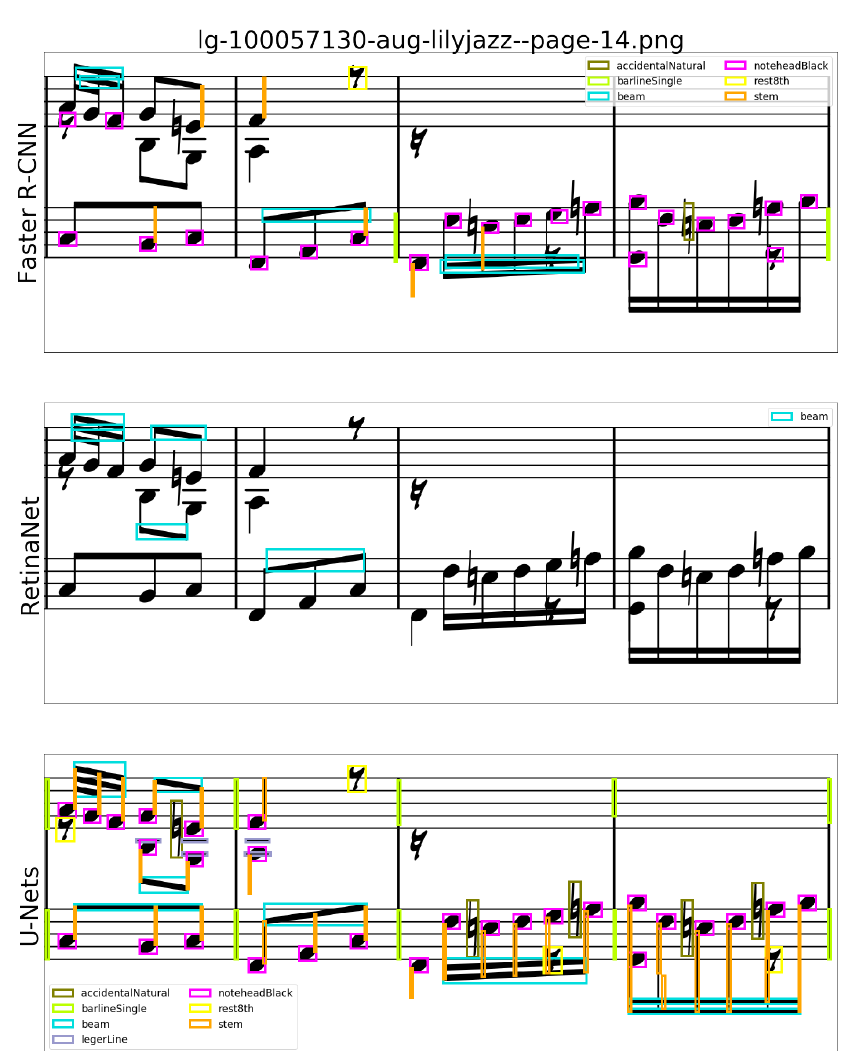
Figure 5. Detection sample on some selected classes from the DeepScores dataset. ( top – bottom ): Faster R-CNN, RetinaNet, and U-Nets detection